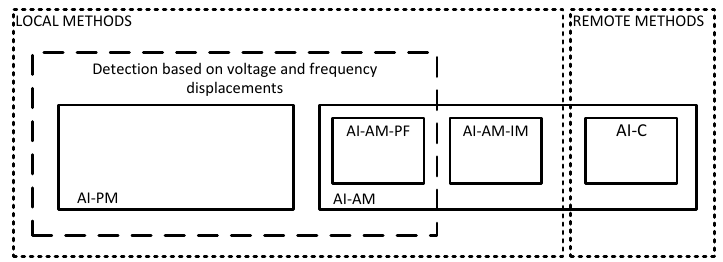
Figure 2. Anti-islanding detection methods’ classification. PM, passive methods; AM, active methods; C, communications; IM, impedance measurement; PF, positive feedback.